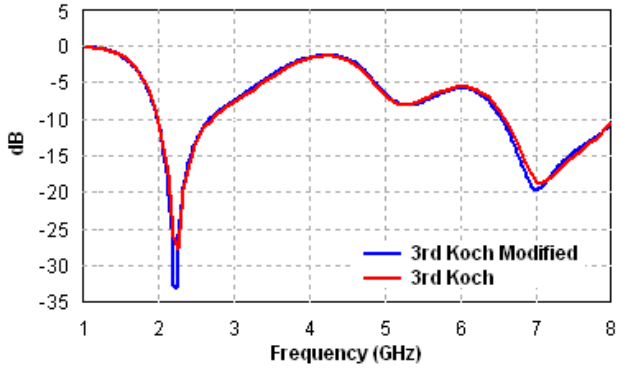
Figure 5: The S 11 responses of the 3rd iteration Koch fractal monopole antenna and the modified monopole antenna.